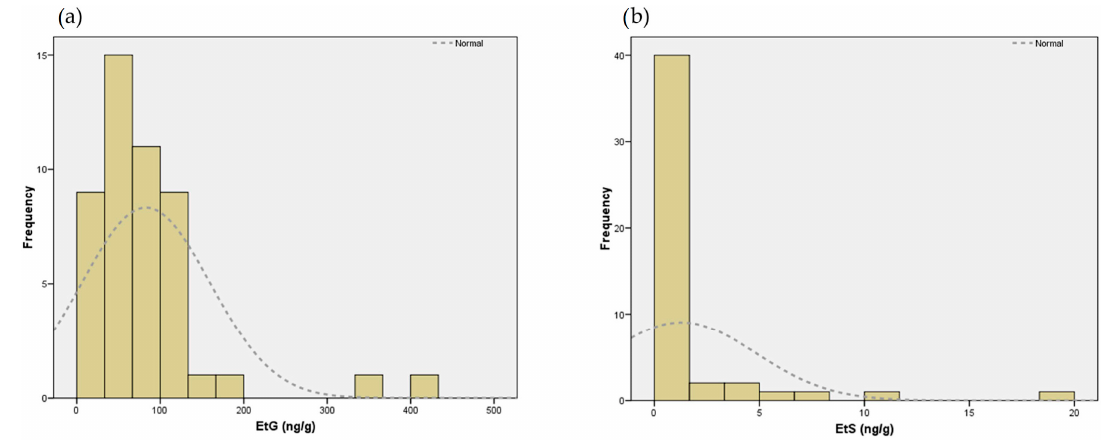
Figure 1. Distribution of two direct metabolites of ethanol in 48 meconium samples: ( a ) EtG; and ( b ) EtS.